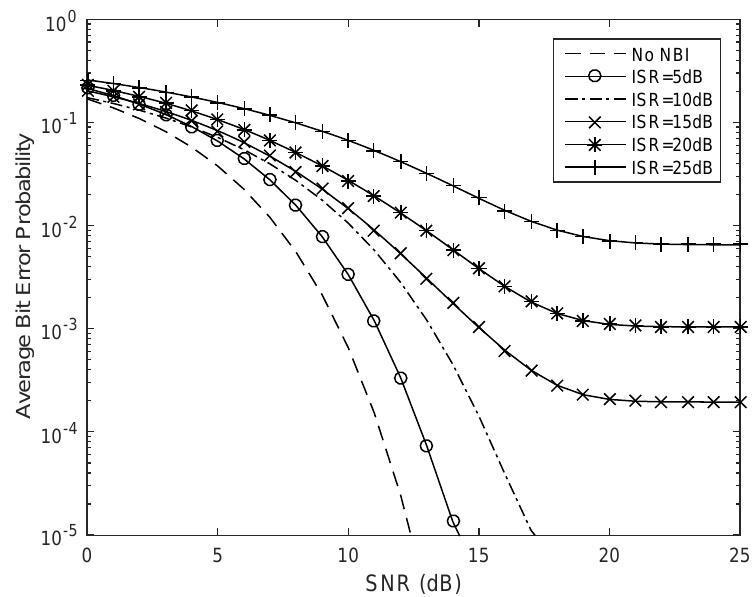
Figure 8. Average bit error probability for the TH-PPM UWB wireless sensors with narrow band interferences under the IEEE 802.15.4a CM1 multipath fading